Question: Briefly state, in one sentence, what is plotted here.
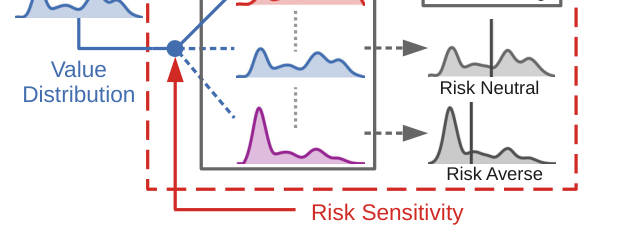
Answer: Application of a risk metric. The risk sensitivity selects how the value distribution is distorted. The mean value of the distorted distribution is provided for Generalized Advantage Estimation.